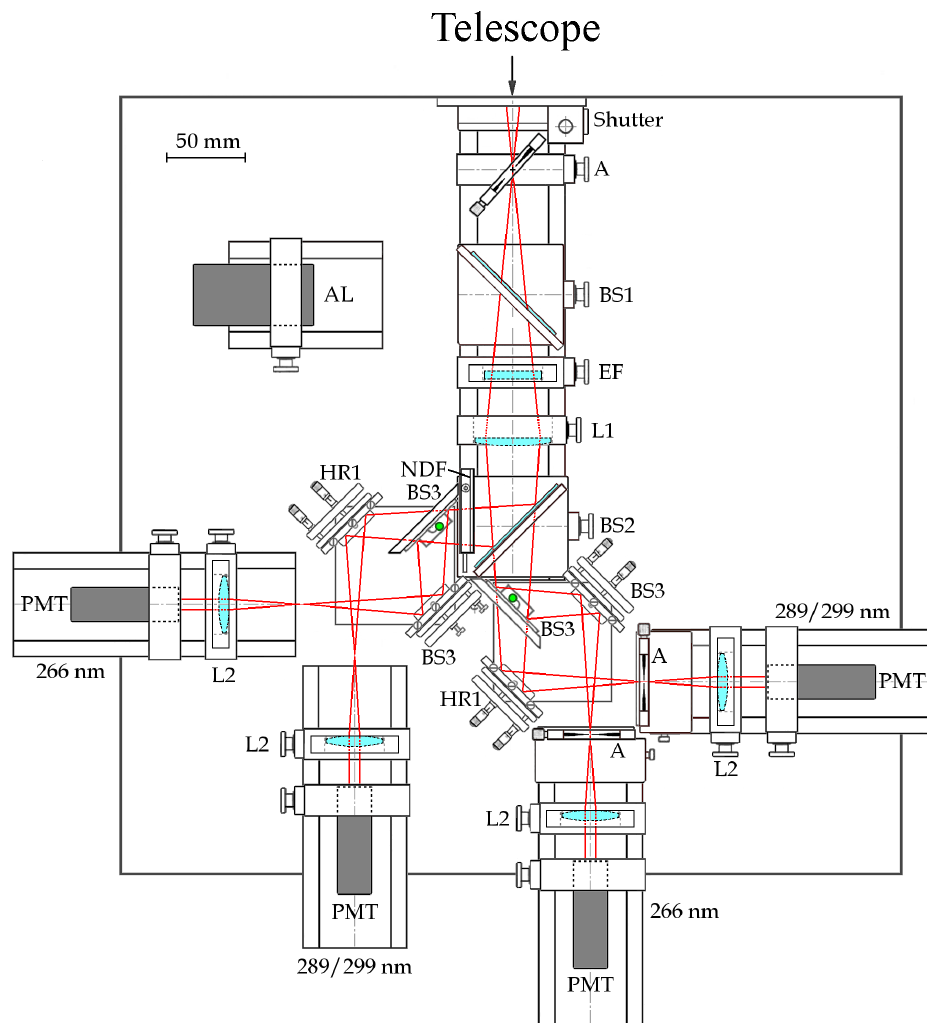
Figure 8. Polychromator of the mobile ozone DIAL: the opto-mechanical components were mounted on a rail system attached to a black optical table with a 25mm × 25mm hole pattern (M6 threads, not shown). The two green dots mark the intermediate image planes of the primary mirror of the telescope (the secondary image planes coincide with the PMT cathodes). Abbreviations are as follows. A: rectangular aperture with four adjustable black blades; BS1: beam splitter for reflecting 532 or 1064nm out of the received radiation for aerosol measure- ments (not implemented); BS2: 1:100 beam splitter for near-field–far-field separation; BS3: dichroic beam splitter with T < 4% for 289 and 299nm; HR1: high-reflecting mirror (45 ◦ ); EF: dielectric edge filter, blocking the radiation above 299nm; NDF: T = 10% neutral density filter; L1: f = 100mm lanes; L2: f = 50mm lens; AL: alignment